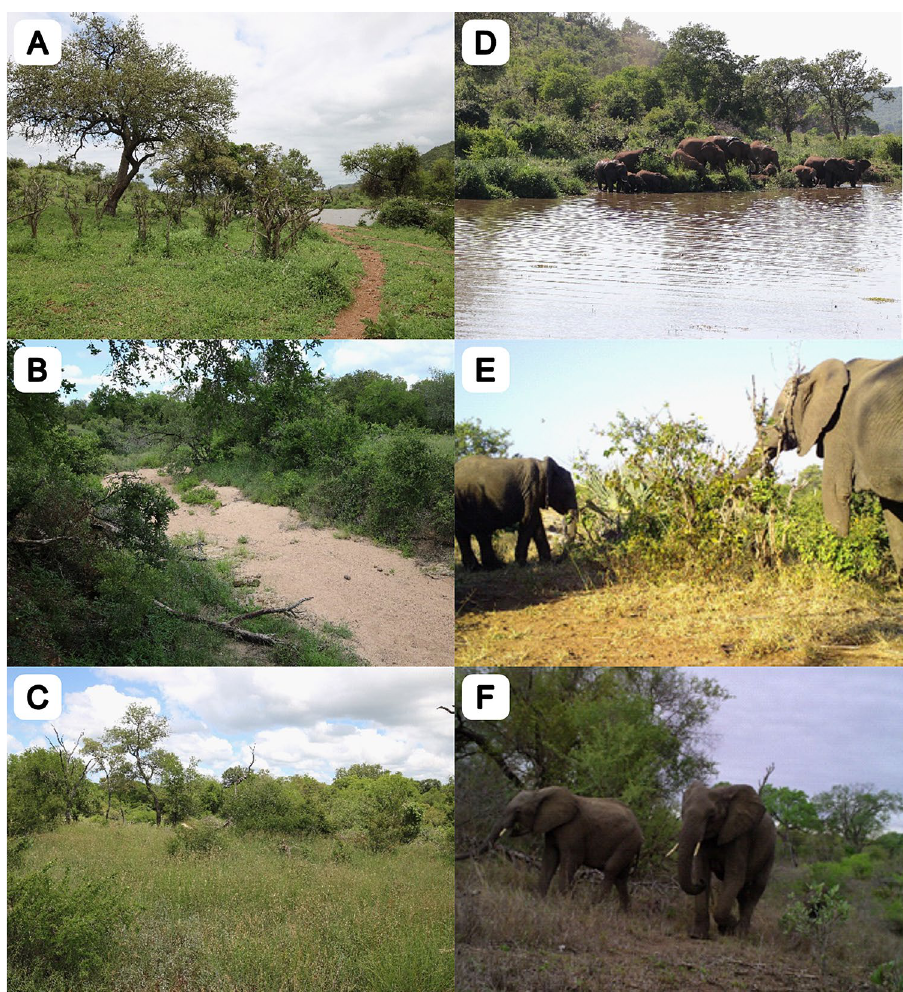
Figure 1. Habitats in the Kruger National Park that were sampled in this study, left column: ( A ) perennial river, ( B ) seasonal river, and ( C ) a dry crest. Right column: Elephants at a perennial plot in rainy ( D ) and dry season ( E ), and at a seasonal river ( F ). Photo: Petr Pyšek ( A – C ), Klára Pyšková ( D – F